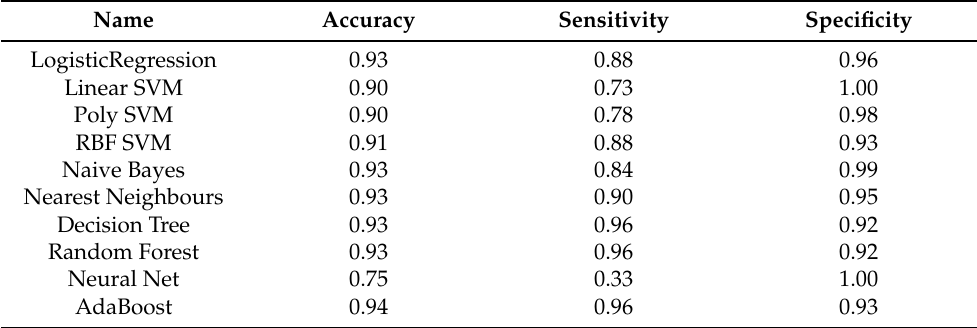
Table 3. Accuracy, sensitivity and specificity for PCA and all tested combinations of the shallow learning methods.